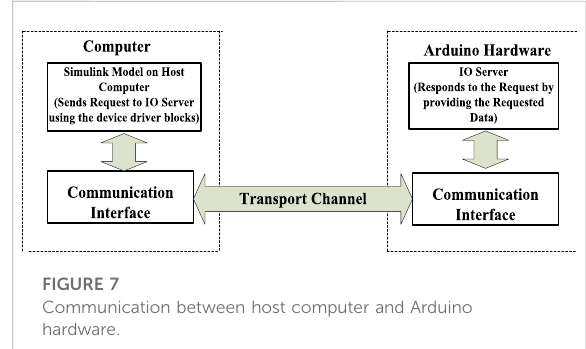
FIGURE 6 Setupforonline transformer incipientfaultdiagnosisusingan E-Nose prototype.